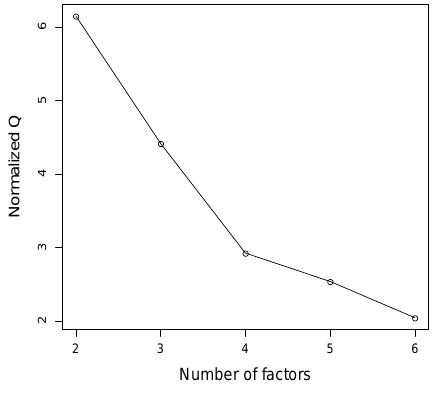
Fig. A2. Normalized Q values versus number of factors for the FTIR Fig.A2. Seelistoffigurecaptions. 54 PMF